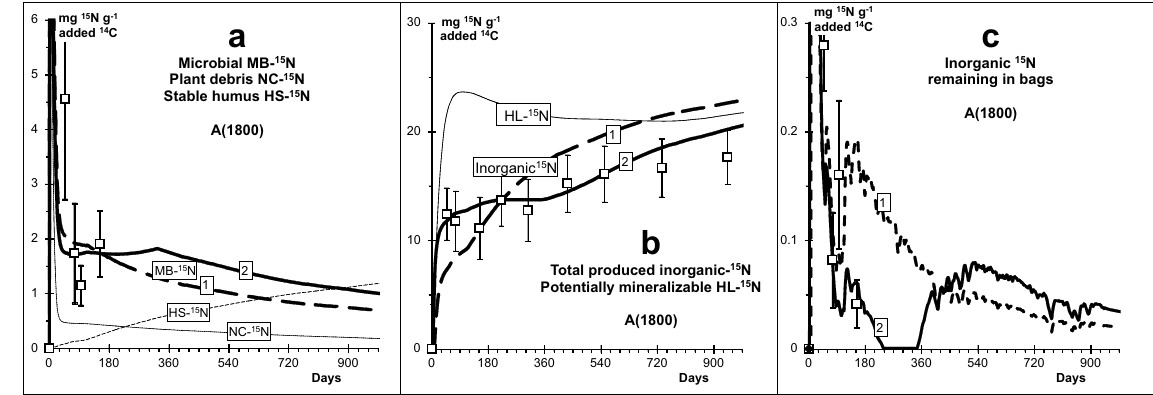
Fig. 4. Measured and simulated values for the mid-altitude site (A1800): squares are measured data with 95% confidence intervals of (a) MB- 15 N, (b) total inorganic- 15 N, (c) inorganic 15 N remaining in bags; heavy dashed lines (1) are the simulated values using assumption 1 of constant C:N ratio of MB; heavy solid lines (2) are the simulated values using assumption 2 (variable C:N ratio of MB) and the first strategy, (a); the light dotted line in (a) is the simulated 15 N in stable humus HS, the light dashed line in (a) is the 15 N remaining in the plant necromass (NC) and the light solid line in (b) is the potentially mineralizable 15 N in the labile humus HL.